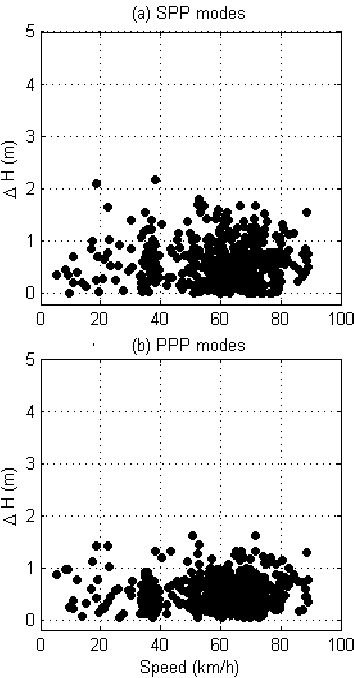
Figure 6. Sensitivity of the positioning error on the vehicle speed in (a) SPP and (b) PPP modes. The correlation coefficients are (a) − 0.02 and (b) +0.02.